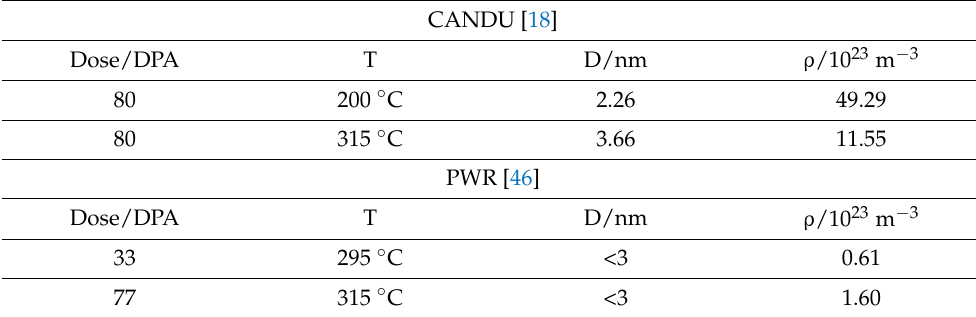
Table 4. Bubble microstructure data for CANDU and